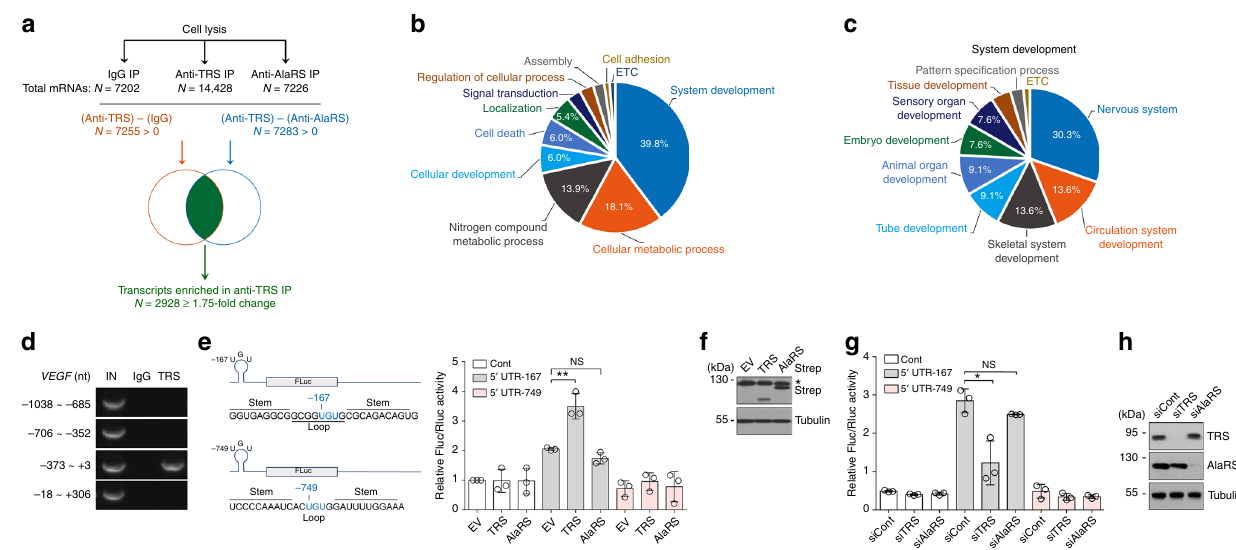
Fig. 4 TRS-mediated translation initiation control of mRNAs in vertebrates. a Work fl ow used to identify TRS-targeted mRNAs. Total mRNAs isolated from 293 T cells were precipitated with anti-TRS or anti-AlaRS antibodies and/or mock IgG, and RNA sequencing of precipitated transcripts was conducted. TRS-enriched RNAs were subtracted from those enriched in AlaRS and IgG groups, and the two RNA pools were compared to identify common transcripts. Among the transcripts commonly detected in both TRS-enriched pools, 2,928 ≥ 1.75-fold were selected, and subsequently subjected to functional annotation. b , c Functional annotation of TRS-targeted mRNAs. Enriched GO terms in the Biological Process category were analyzed using the Database for Annotation, Visualization and Integrated Discovery (DAVID). d RNA immunoprecipitation of endogenous TRS in 293T cells followed by reverse transcription-PCR using primers within the 5 ′ -UTR of VEGF mRNA. IN, input; nt, nucleotide. e Potential tRNA Thr anticodon triplet (UGU)-containing stem- loop structures were observed at positions -167 and -749 upstream from the VEGF mRNA initiation codon. The two RNA sequences spanning positions -1 to -540 (5 ′ -UTR-167) and -541 to -1,038 (5 ′ -UTR-749) were fused upstream of the fi re fl y luciferase gene ( Fluc ) and co-expressed with the Renilla luciferase gene ( Rluc ) in TRS- or AlaRS-expressing 293T cells. Data are presented as the ratio of fi re fl y to Renilla luciferase activity (Fluc/Rluc). f Immunoblot analysis of TRS-Strep and AlaRS-Strep in TRS- or AlaRS-expressing 293 T cells using Strep antibody. * indicates a nonspeci fi c band. g Translation of the pseudo- anticodon-containing reporter gene in siTRS- or siAlaRS-transfected 293 T cells. siCont, non-targeting control siRNA. h The effect of knock-down of TRS